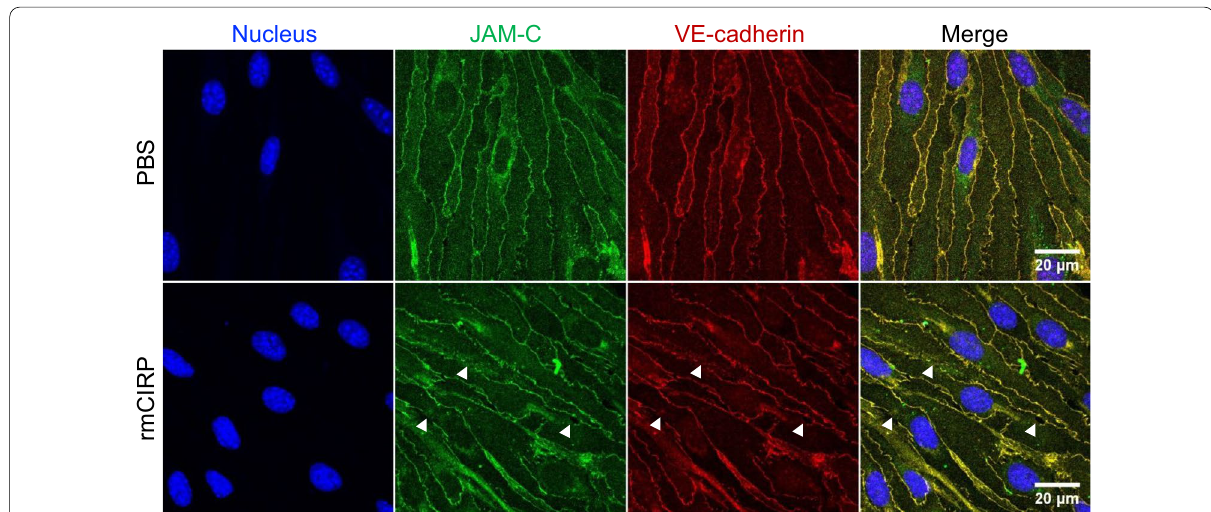
Fig. 2 eCIRP decreases cell-to-cell junction of endothelial cells. A The endothelial cells cultured on an 8-chambered glass slide were treated with PBS or eCIRP (0.5 µg/mL) for 4 h and were fixed and subjected to immunostaining with antibodies JAM-C (green color) and VE-cadherin (red color). Hoechst33342 was used for nuclear staining and colored in blue. The arrowhead shows junctional disruptions in the endothelial cell layer. Scale bar, 20